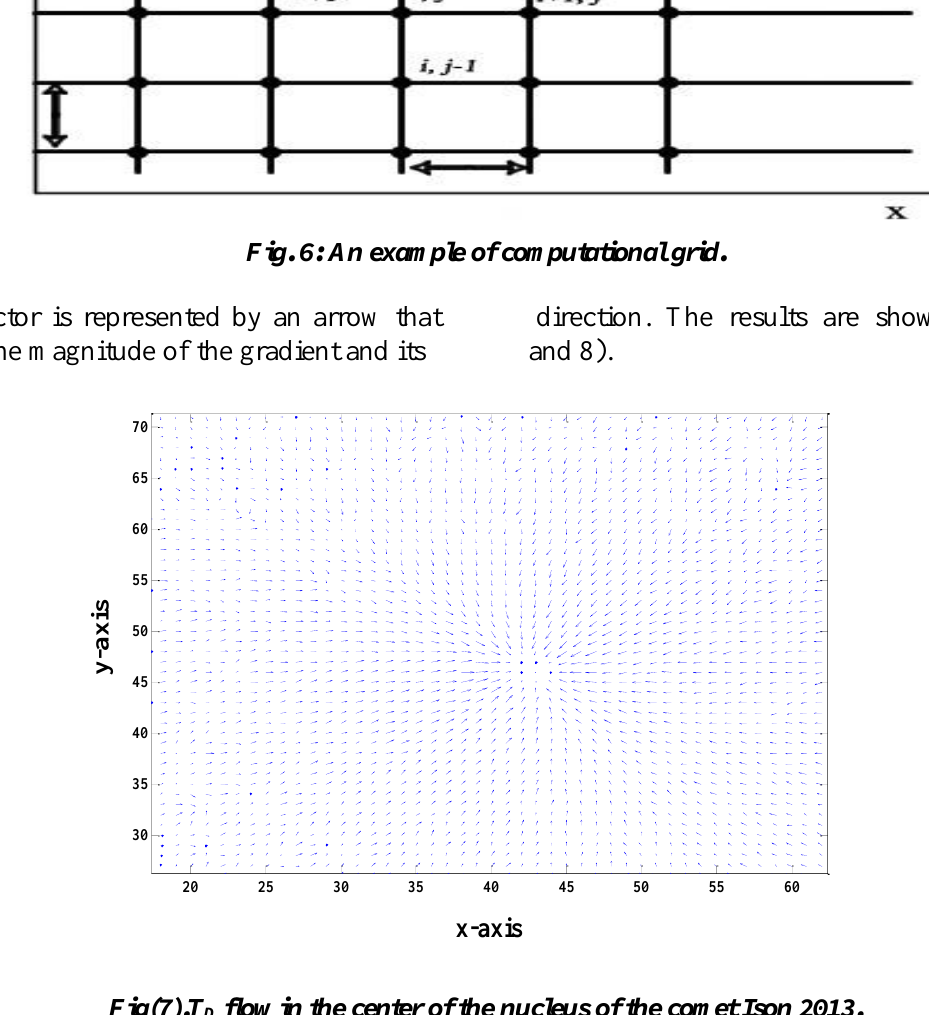
Fig(7).T flow in the center of the nucleus of the comet Ison D